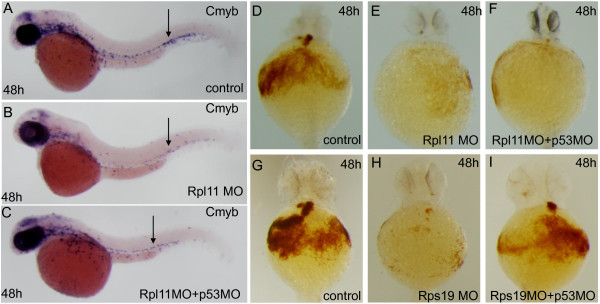
Rpl11 deficiency is required for hematopoietic defects through p53-independent pathways in zebrafish embryos. A-C, Rpl11 is required for HSC formation through p53-independent pathways. The expression of cmyb was significantly decreased in Rpl11 morphants and in Rpl11 and p53 double morphants at 48 hpf compared with that in control embryos. D-I, Rpl11 deficiency caused defective hematopoietic phenotypes in zebrafish embryos through p53-independent pathways. Hemoglobin staining of embryos individually injected with Rpl11 MO or Rps19 MO and coinjected with p53 MO were performed. D and G are controls, E and H are Rpl11 MO or Rps19 knockdown, and F and I are Rpl11 MO and Rps19 MO coinjected with p53 MO, respectively. Panel A–C, lateral views; D-I, ventral views.